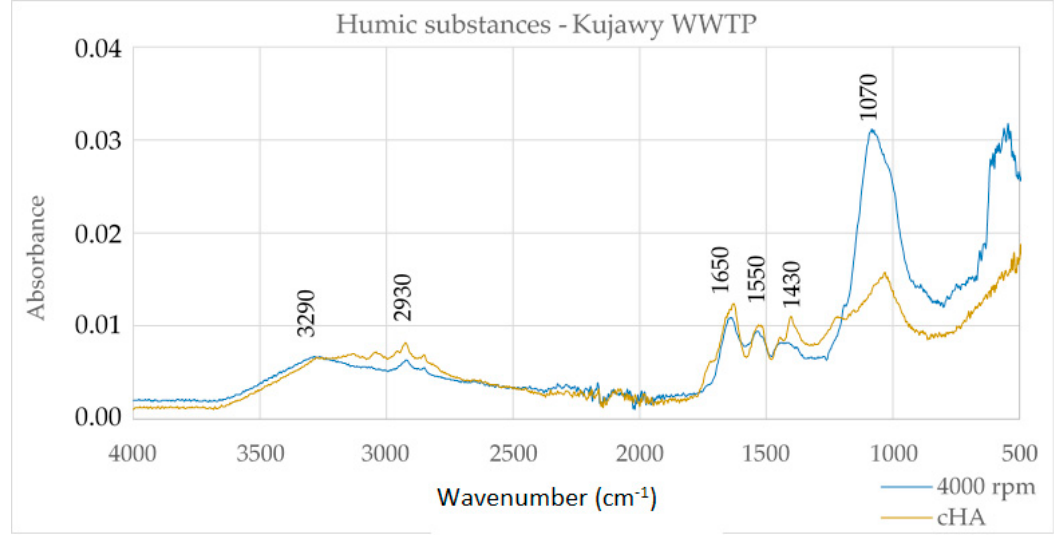
Figure 2. Infrared (FTIR) spectra of HS extracted from digested sludge of the Kujawy WWTP (author’s method) and cHA (classical method by IHSS).